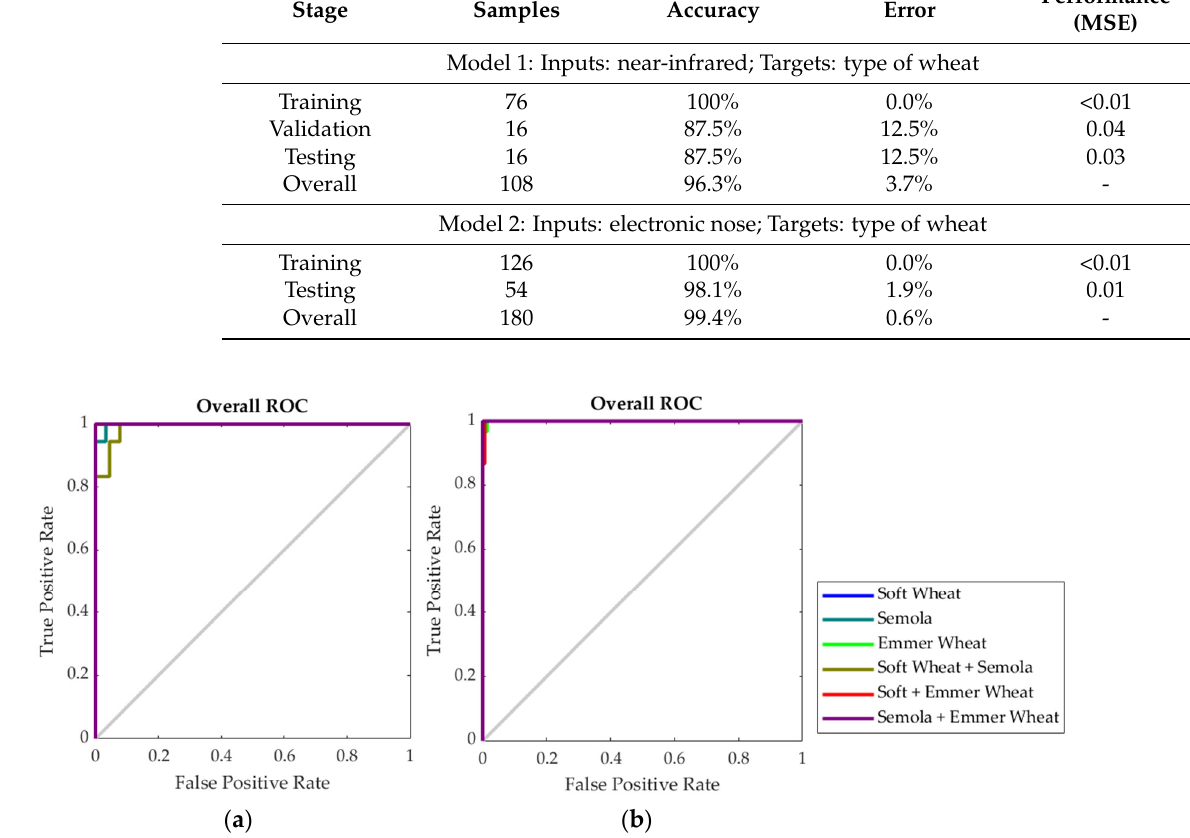
Figure 8. Receiver operating characteristics (ROC) curves for ( a ) Model 1 and ( b ) Model 2.